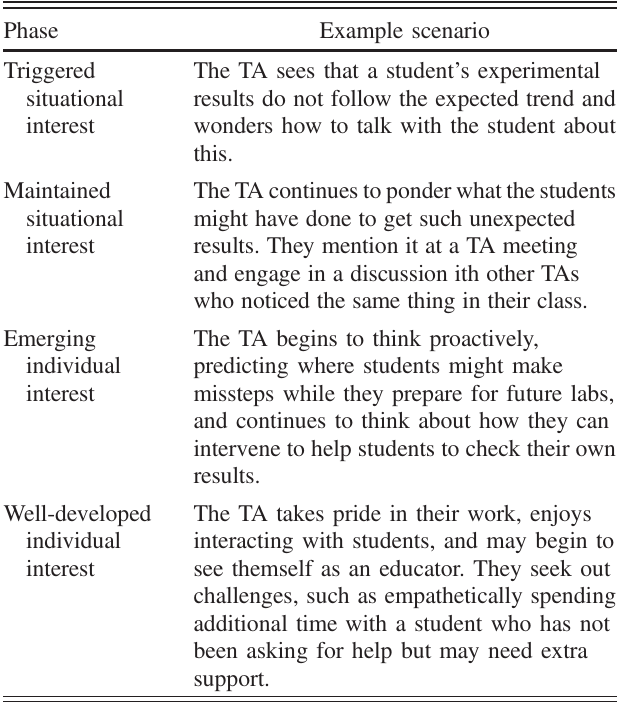
TABLE I. Example of how a TA ’ s interest might evolve accord- ing to four-phase interest development theory when appropriately supported by a professional development program [36]. Phase Example